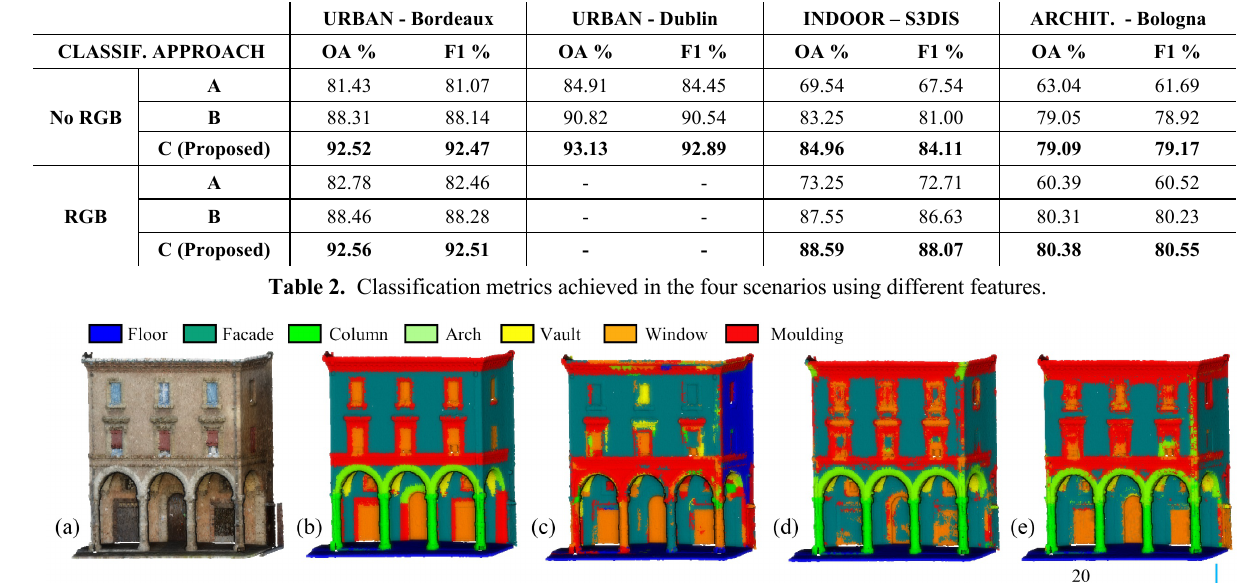
Figure 4. Examples of geometry-based features: from top to bottom Omnivariance, Verticality and Surface Variation.